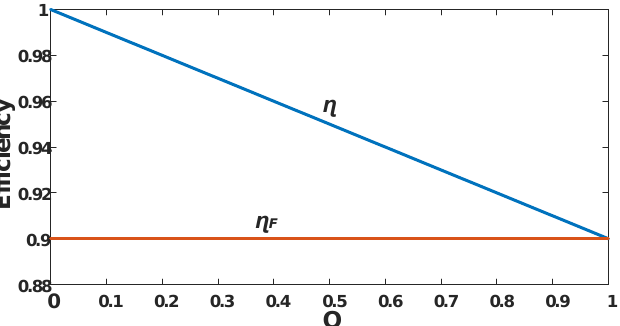
Figure 10. Estimated efficiency of the proposed converter vs Q .